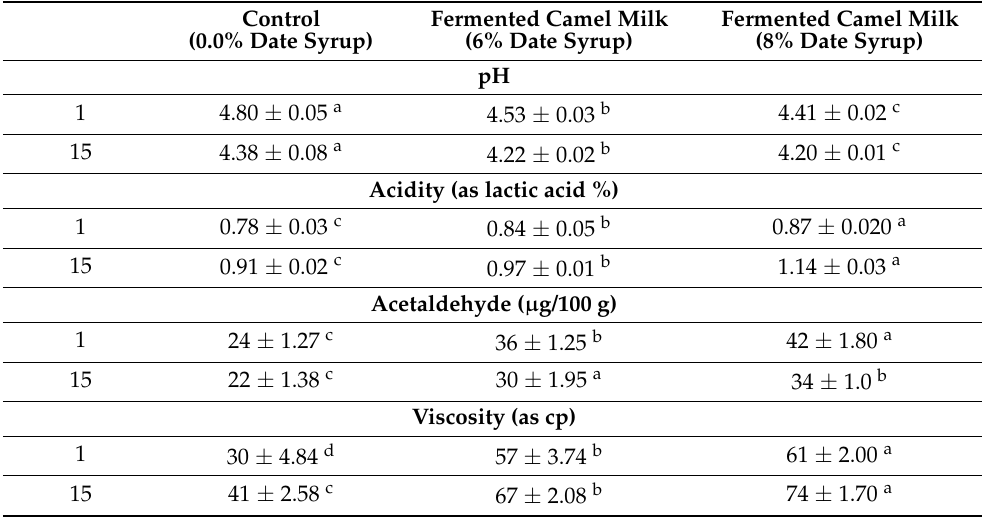
Table 3. Influence of the addition of date syrup on the pH, acidity, viscosity values, and acetaldehyde content of camel milk yogurt during cooled storage